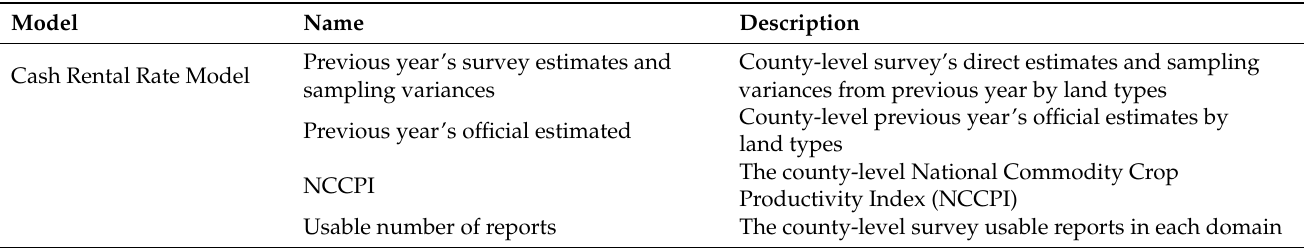
Table A3. The covariate definitions for the cash rental rate